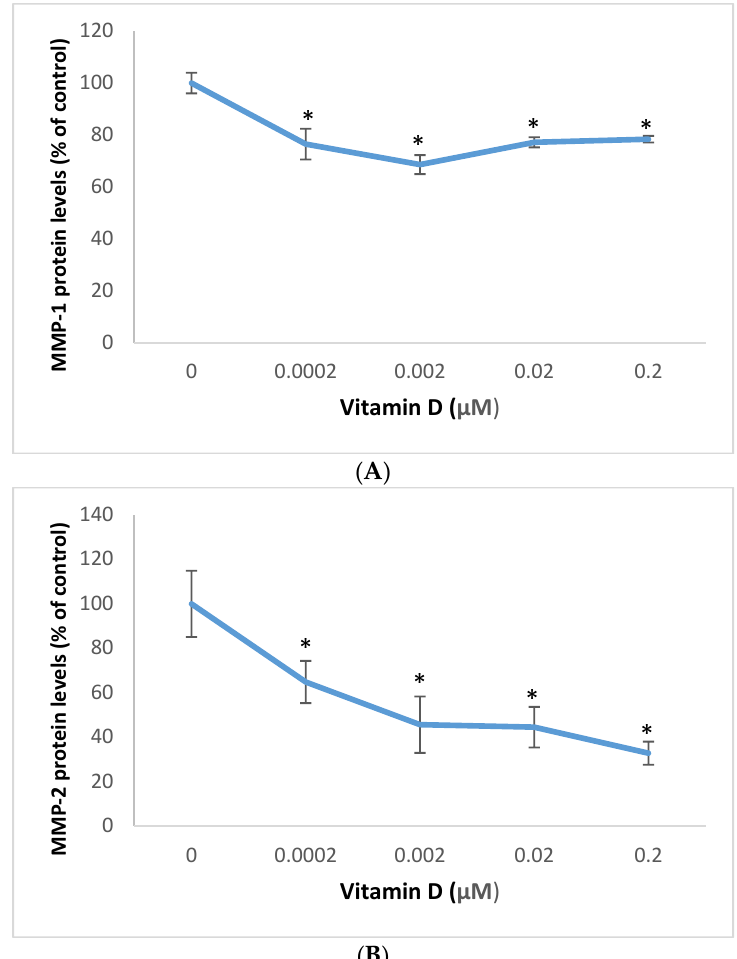
Figure 7. Effect of 1 α ,25-dihydroxyvitamin D3 (vitamin D) on Matrix metalloproteinase (MMP)-1 ( A ), and MMP-2 ( B ) protein levels in melanoma cells; error bars: standard deviation, n = 4; * = p < 0.05, relative to control.